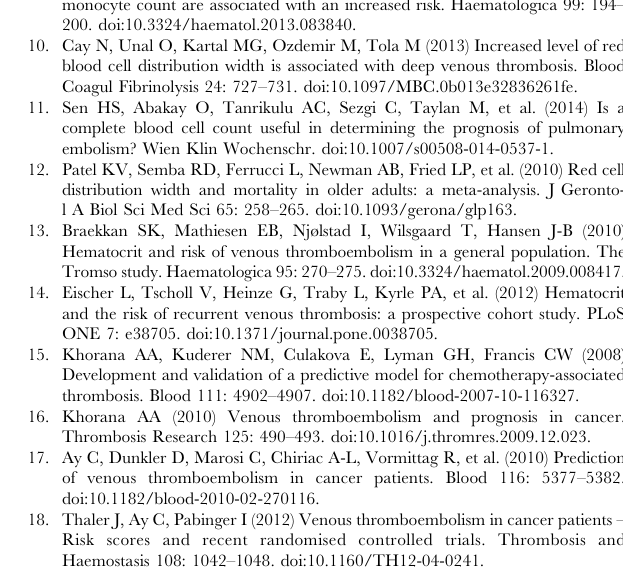
Table S1 Characteristics of patients with RDW . 16% and